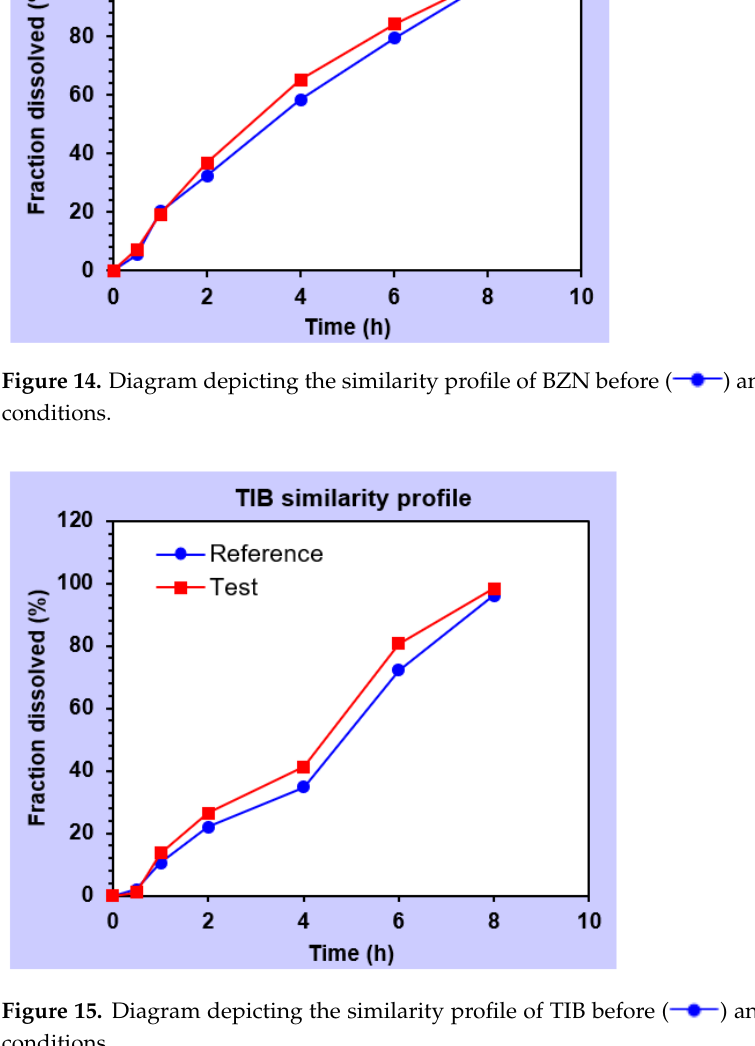
Figure 15. Diagram depicting the similarity profile of TIB before ( ) and after ( ) stability conditions.